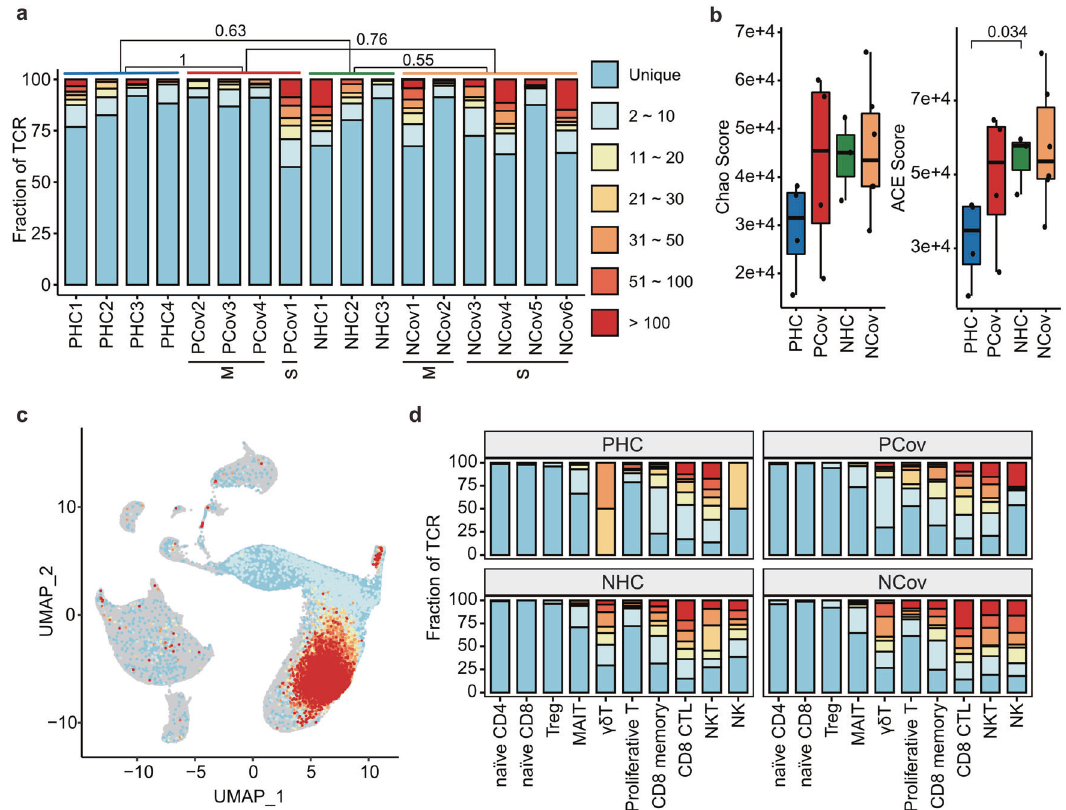
Fig. 4 T cell clonality in response to COVID-19. a The frequency of TCR repertoires in all donors. The severity level is also shown. The frequencies of the expanded clones (clone ≥ 2) were compared among all the groups, Wilcoxon rank-sum test. b The clonal diversities differ between PHC and NHC while similar between PCov and NCov. The diversities were evaluated using the ACE and Chao indices (Borcherding et al. 71 ). p Values of Wilcoxon rank-sum test are shown. PHC pregnant healthy controls (blue), PCov pregnant COVID-19 patients (red), NHC non-pregnant healthy controls (green), NCov non-pregnant COVID-19 patients (orange). c UMAP projection of TCR repertoires. d Percentages of TCR repertoires identi fi ed in the T cell “ CDC42 signaling ” and “ Fc γ receptor-mediated phagocytosis in intermediate monocytes from pregnant donors were more responsive to SARS-CoV-2 spike protein by upregulating HLA-DR macrophages and monocytes ” was activated in the PCov groups (Fig. 7a – c). In contrast, non-classical monocytes from non- while inhibited in the NCov groups (Fig. 6f), indicating that non- pregnant donors were more responsive to SARS-CoV-2 spike classical monocytes were more active in PCov than in NCov. protein by upregulating CD83 (Supplementary Fig. 7). Differential IFN responses in monocyte compartment during pregnancy DISCUSSION To investigate the unique immunological features of COVID-19 during pregnancy, we performed single-cell mRNA sequencing and single-cell TCR sequencing for PBMCs isolated from the recovered pregnant and non-pregnant COVID-19 patients as well as their equivalent healthy controls. Our data present a unique feature in both innate and adaptive immune responses in pregnant patients recovered from COVID-19. Similar to other respiratory viral infections, T cells and B cells play a prominent role in SARS-CoV-2 infection. 44 The published data reported that patients with severe COVID-19 can have either insuf fi cient or excessive T cell responses, 5,45 indicating a protective role of proper T cell response in defense against SARS-CoV-2. Meanwhile, over 30% COVID-19 patients showed increased plasmablasts and proliferation of memory B cells. 4 We observed prolonged lymphopenia in the pregnant patients, indicating potentially suppressed lymphoid response, and consistently, molecules involved in BCR or TCR signaling are generally downregulated in the pregnant groups. However, we also found that pathways related to T or B cell activation, migration, and virus defense were upregulated in the pregnant patients compared to